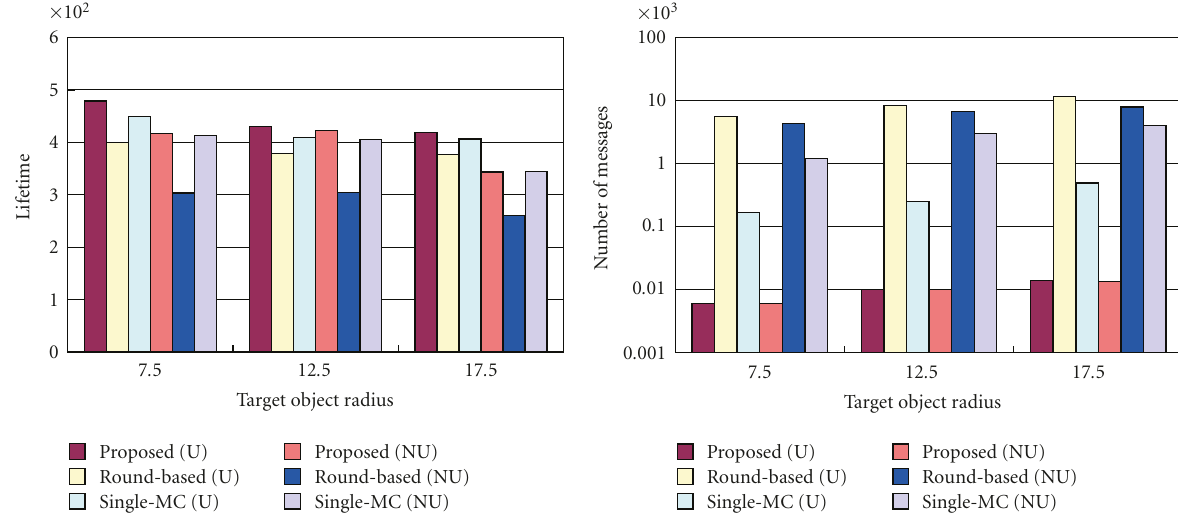
Figure 15: Varying target object radius scenario.